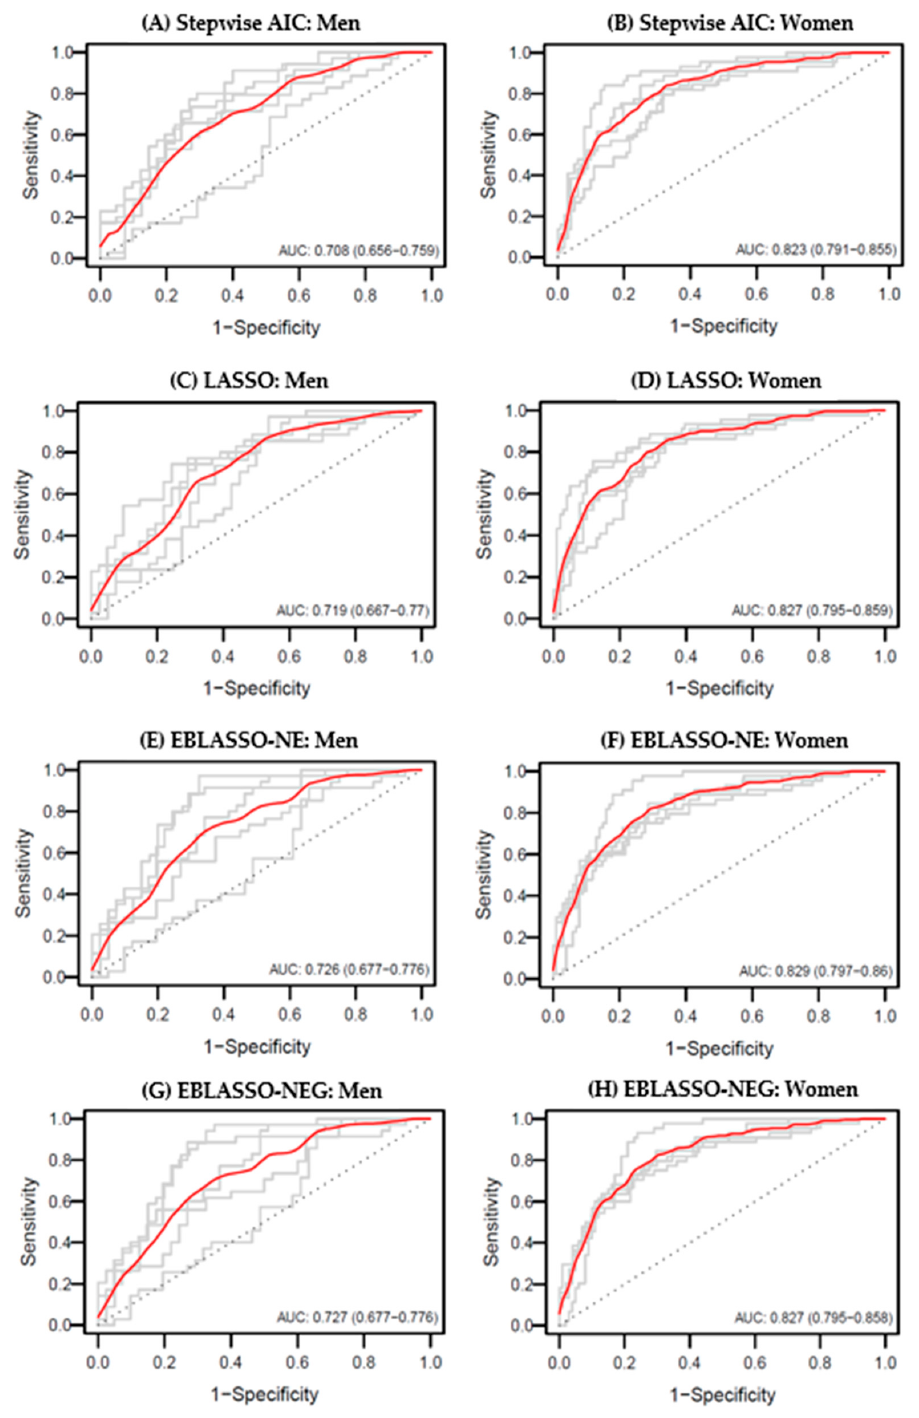
Figure 3. Roc curves for ( A ) Stepwise AIC model of men, ( B ) Stepwise AIC model of women, ( C ) LASSO model of men, ( D ) LASSO model of women, ( E ) EBLASSO-NE model of men, ( F ) EBLASSO-NE model of women, ( G ) EBLASSO-NEG of men, and ( H ) EBLASSO-NEG of women using 5-fold cross-validation. Grey lines show individual ROC curves for 5-fold cross-validation, and the red line shows the average of individual ROC curves. LASSO, least absolute shrinkage and selection operator; Stepwise AIC, Stepwise Akaike information criterion; EBLASSO-NE, the empirical Bayesian LASSO with two-level hierarchical prior, Normal and Exponential distribution; EBLASSO-NEG, the empirical Bayesian LASSO with three-level hierarchical prior, Normal, Exponential and Gamma distribution; AUC, area under the receiver operating characteristic curve using 5-fold cross-validation; ROC, receiver operating